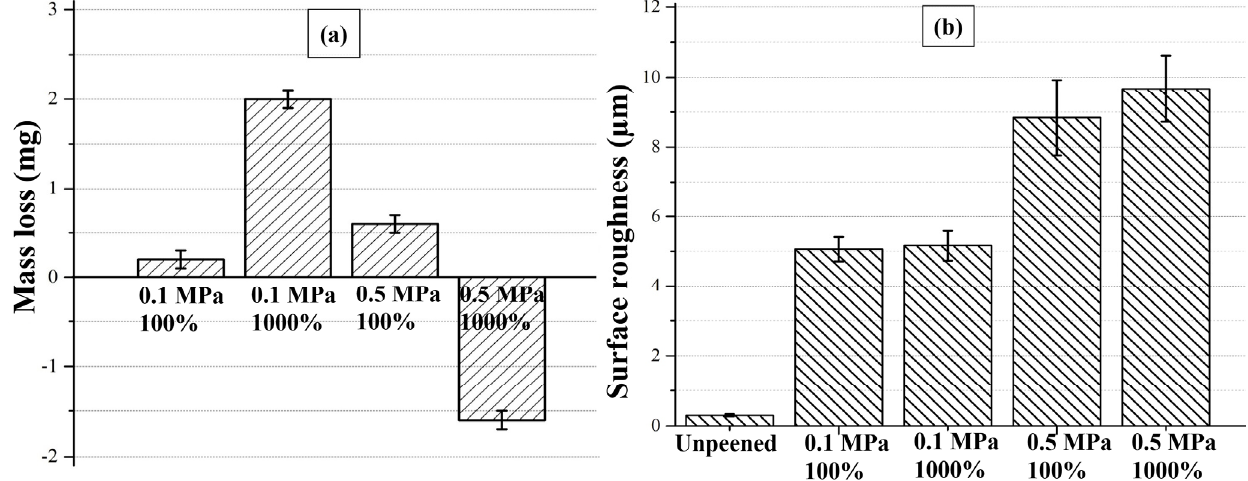
Figure 7. ( a ) Mass loss and ( b ) arithmetic average surface roughness (Ra) as a function of SP pressure and cover rate.